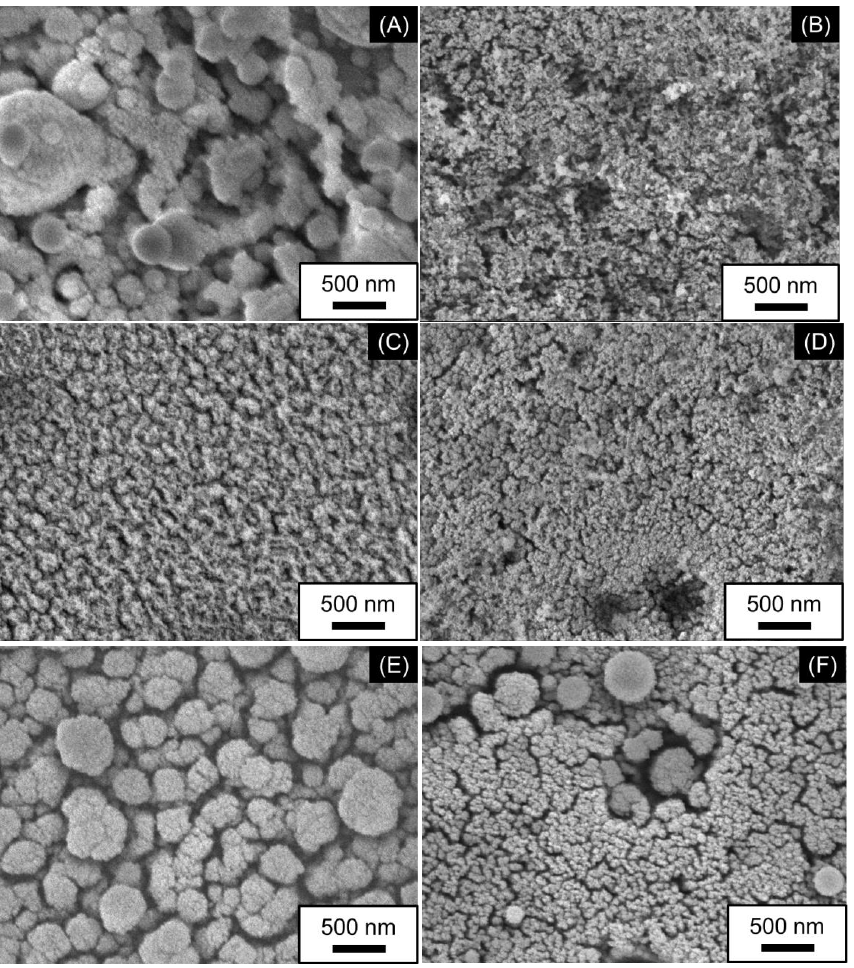
Figure 5. SEM images of TiO 2 thin films ( A ) without and ( B ) with water vapor for He = 5 L/min, ( C ) without and ( D ) with water vapor for He = 5 L/min + Ar = 50 mL/min, and ( E ) without and ( F ) with water vapor for He = 5 L/min + Ar = 300 mL/min.